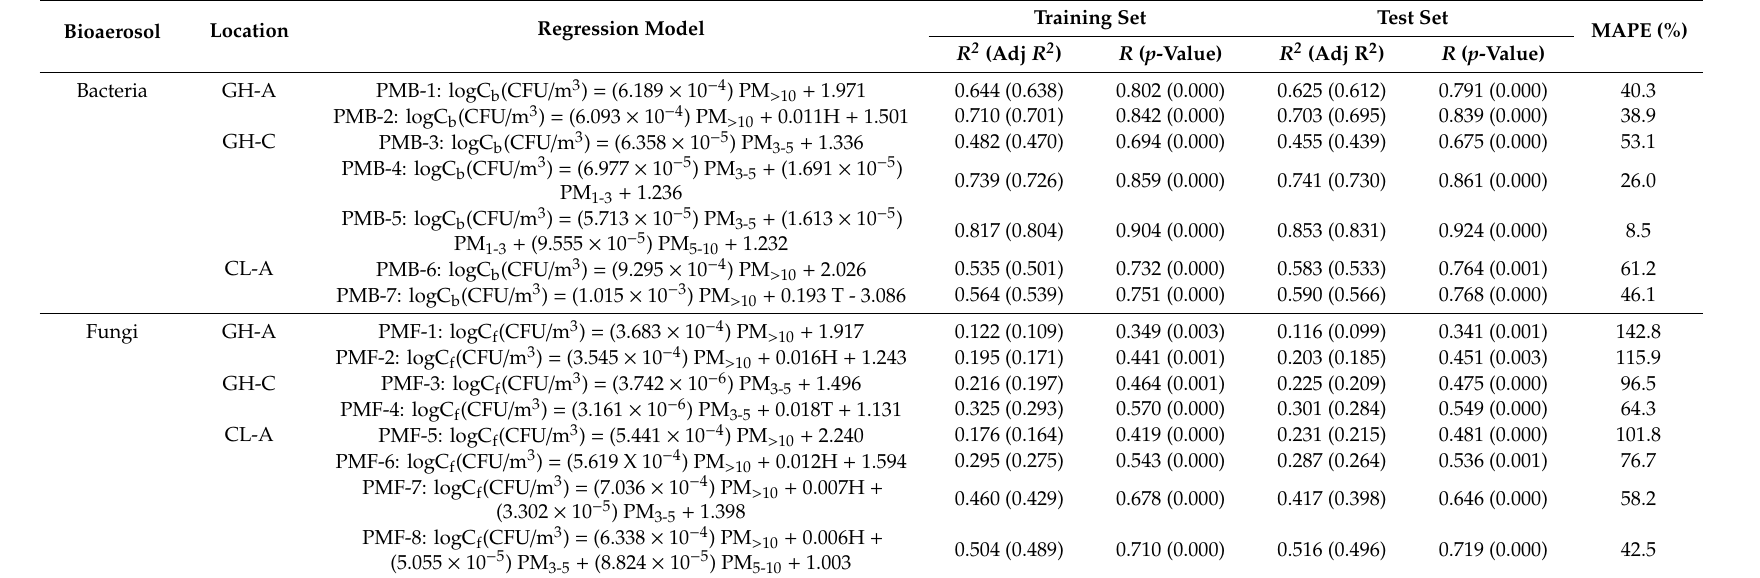
Table 3. Prediction models for bacterial and fungal bioaerosols and evaluation of the predictive ability of each model. The R 2 value of the prediction model calculated through the test set and the forecasting accuracy (mean absolute percentage error (MAPE)) are additionally shown in this